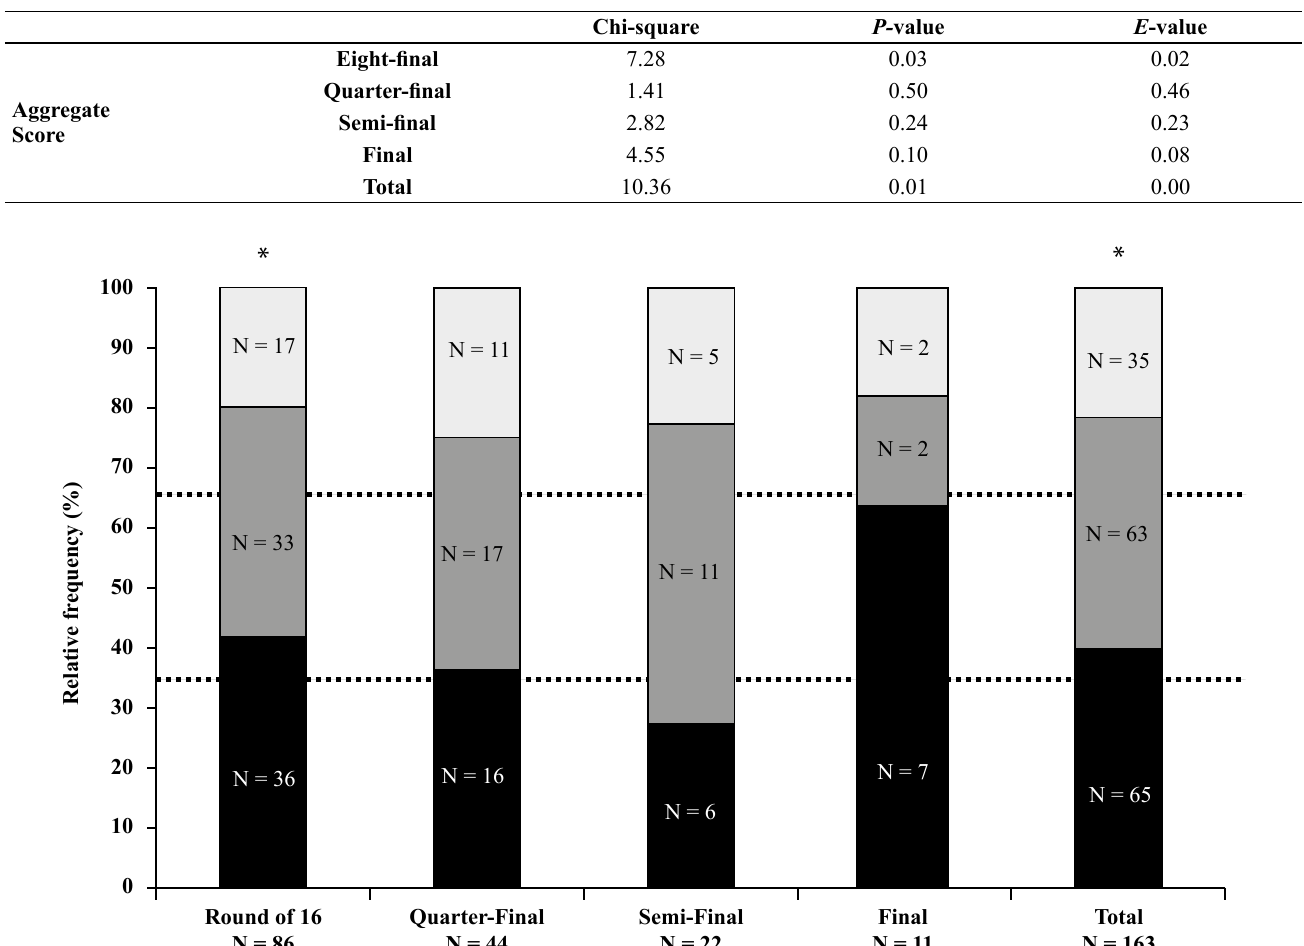
Table 1. Chi-square and Full Bayesian Significance Tests (P- and E-value, respectively) for comparison between the occurrences of home, draw or away results in the aggregate result (second-leg home advantage concept).